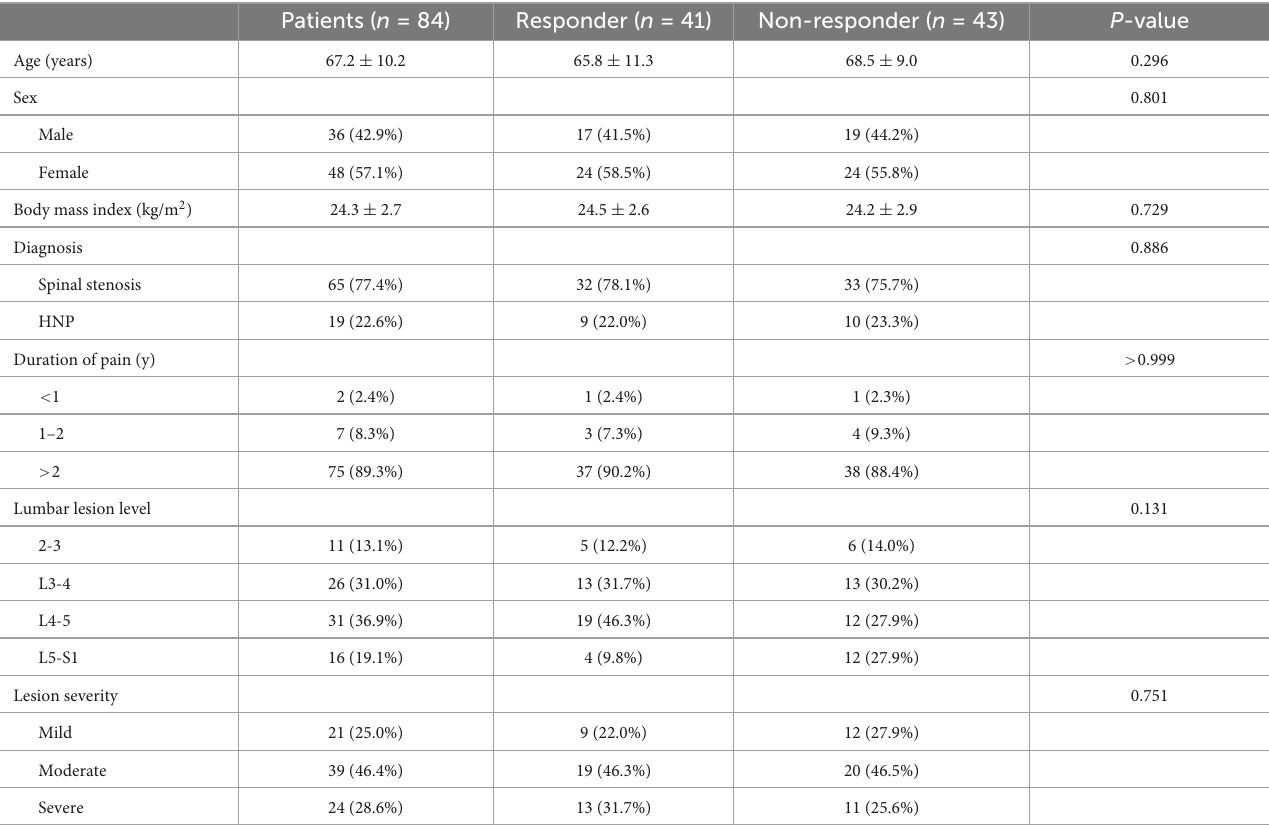
TABLE 1 Demographic and clinical characteristics of the